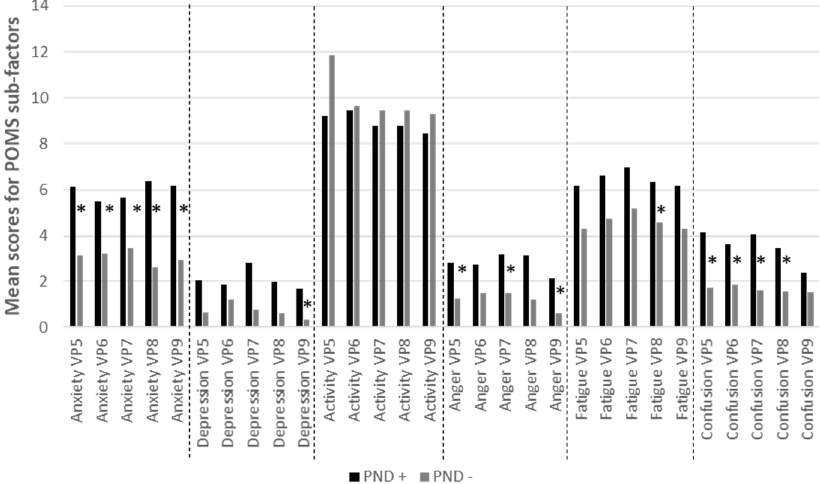
Figure 2. Differences between the two PND groups in their POMS mean sub-scores. Differences were tested with a Mann-Whitney test, *: p <